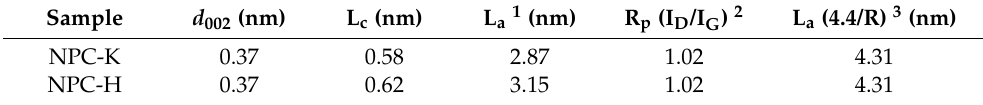
Table 2. Structural parameters of NPC-K and NPC-H, deduced from XRD diffraction and Raman spectra.